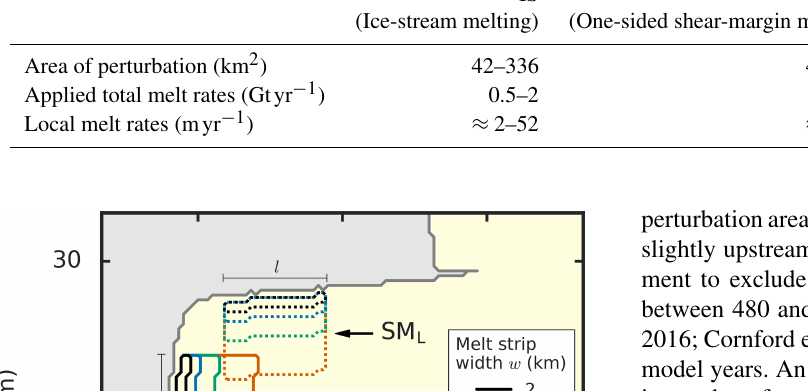
Figure 2. Steady-state ice surface speed for (a) the entire model domain and (b) the grounding-line region. Grounding line and calving front represented by black contours. Table 2. Ranges of perturbation areas and melt rates for each of the three perturbation experiments. IS